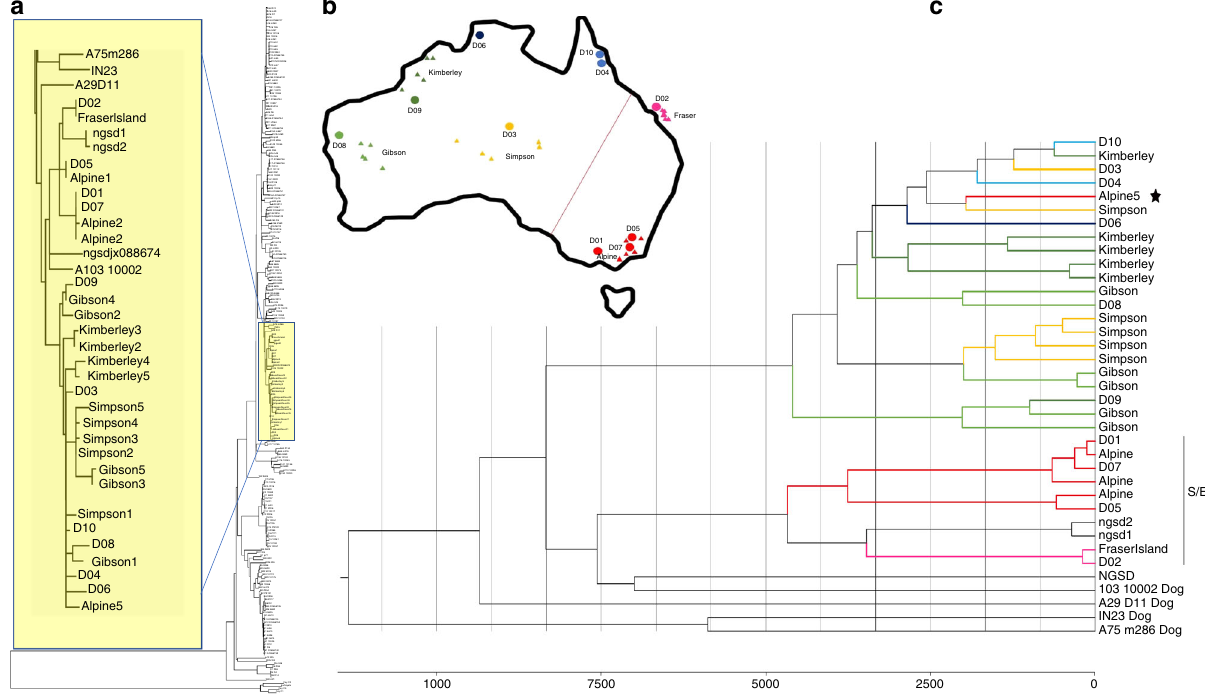
Fig. 3 Phylogenetic and demographic history analysis of mtDNA. a Neighbor-joining tree based on mitochondrial genomes from 35 dingoes and 3 NGSDs, and from 169 domestic dogs and 8 wolves from across the Old World, with 4 coyotes as outgroup. The yellow box and inset fi gure indicate the branch in which all dingoes and NGSDs cluster together with a single domestic dog from South China, and the 3 most closely related dogs outside this branch. b Map depicting geographic sampling of dingoes across Australia. Circles represent the 10 individuals sequenced in this study and triangles 25 additional samples from Cairns et al. The red line indicates the genetic subdivision between the southeastern/eastern part (S/E) and the rest of the continent. c Bayesian analysis of mitochondrial genomes for the sub-dataset identi fi ed in Fig. 3. The dingo/NGSD branch including all dingoes and NGSDs and a single South Chinese domestic dog and, as outgroup, the three most closely related dogs outside that branch. The scale axis indicates time estimates using the mutation rate of 7.7 × 10 − 8 per site per year with SD 5.48 × 10 − 9 from Thalmann et al. 49 . The colored branches indicate geographical origin of dingo samples, see Fig. 2. The star highlights the single dingo sample from southeast Australia that does not cluster in the S/E-related